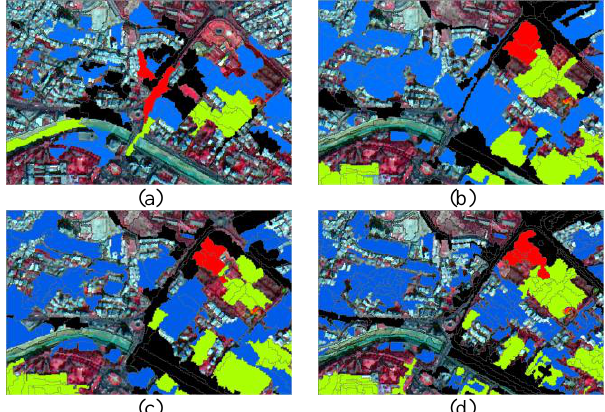
Figure 6. Selected training samples for each class before editing. (a), (b), (c), (d) show training data for segmentation level I, II, III and IV respectively.